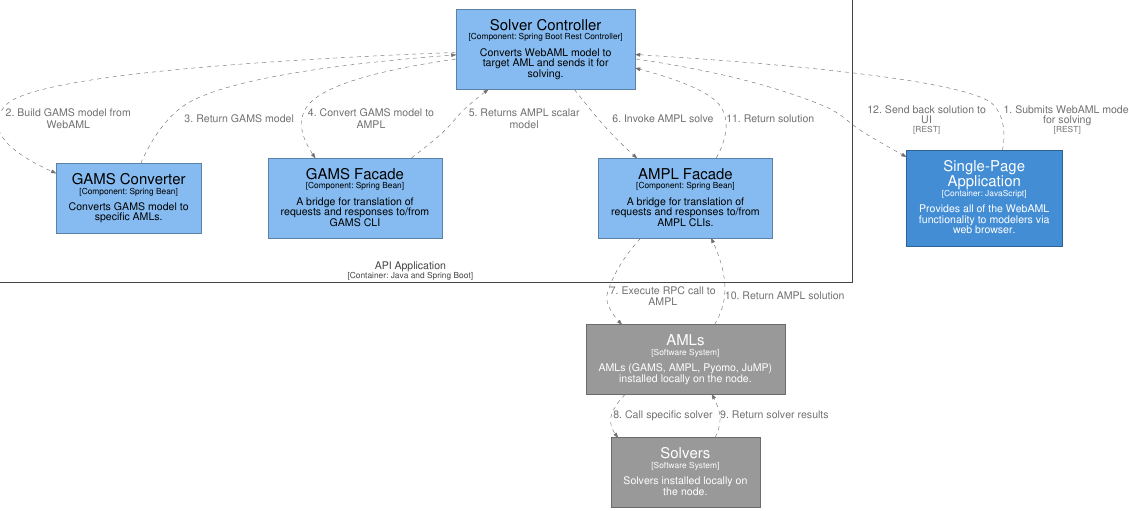
Figure A2. End-to-end flow to solve the WebAML model using AMPL. This showcases the usage of GAMS Convert if a native WebAML to AMPL converter is not